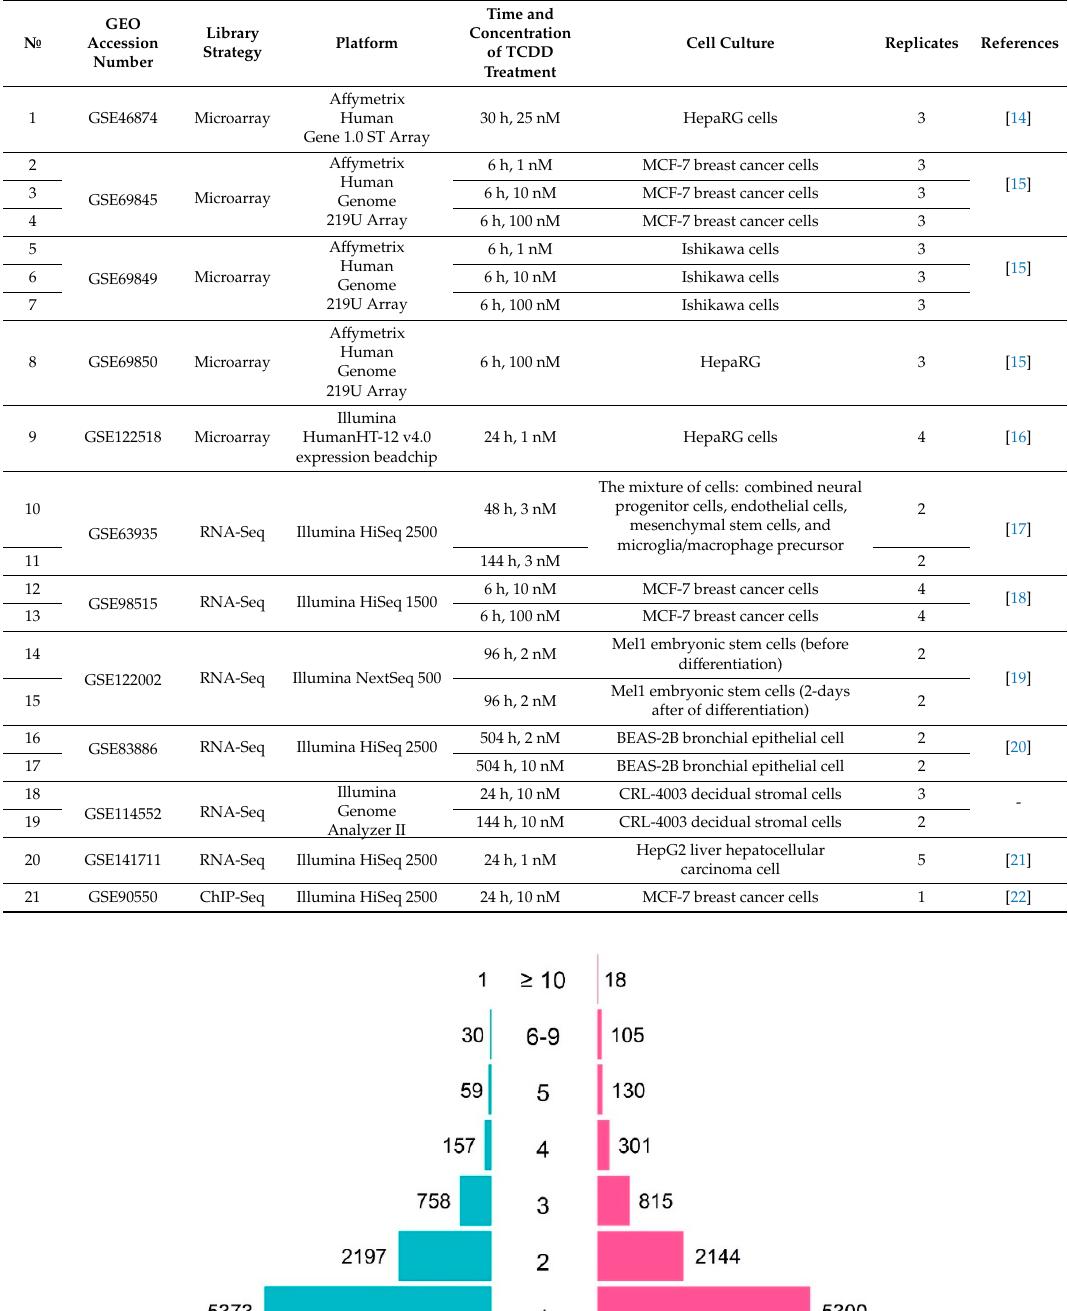
Table 1. Summary on the datasets for the studies of 2,3,7,8-tetrachlorodibenzo- p -dioxin (TCDD) action on the human cell cultures used in the meta-analysis. Only datasets that passed the quality control are presented. GEO: Gene Expression Omnibus.